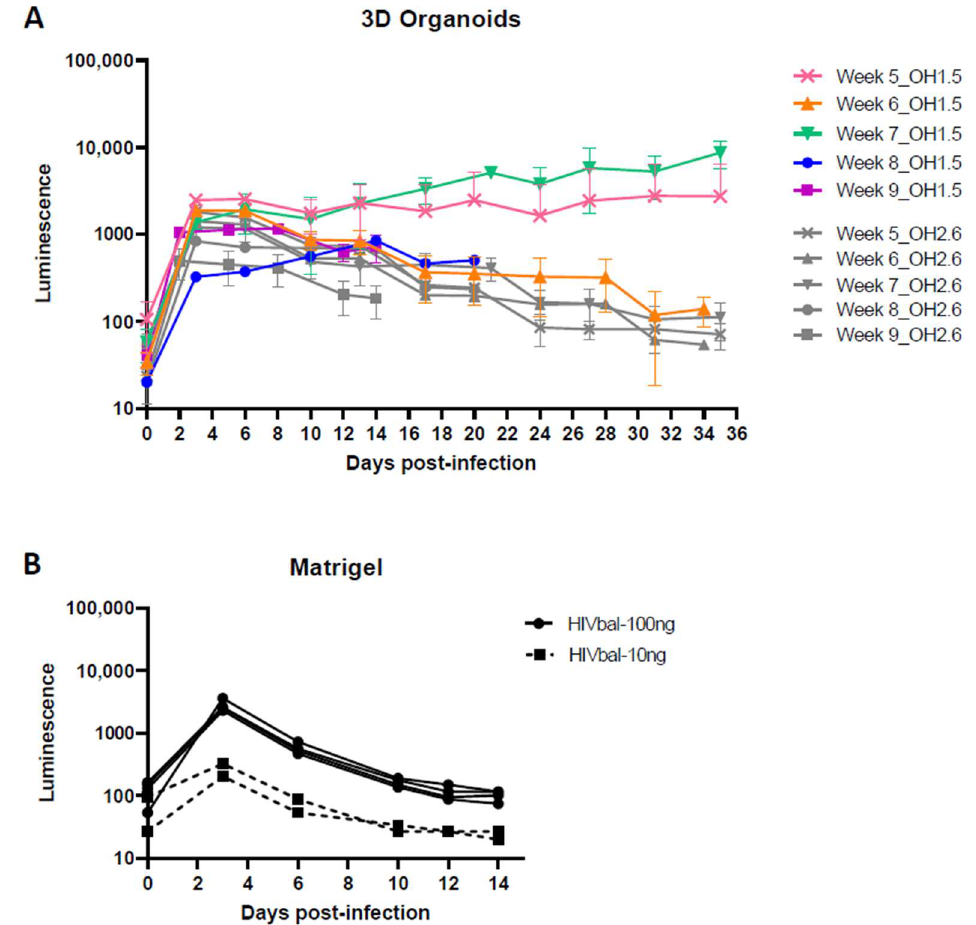
Figure 6. HIV infection of 3D organoids. ( A ) Three-dimensional cerebral organoids, starting from week 5 up to week 9, were infected with 100 ng (p24 Gag) HIVbal. Cerebral organoids were derived from iPSC line OH1.5 and OH2.6. ( B ) Matrigel droplets were infected with 10 ng and 100 ng (p24 Gag) HIVbal. Supernatant was collected at each timepoint and analyzed for luciferase activity. The means ± standard errors of the means are shown.